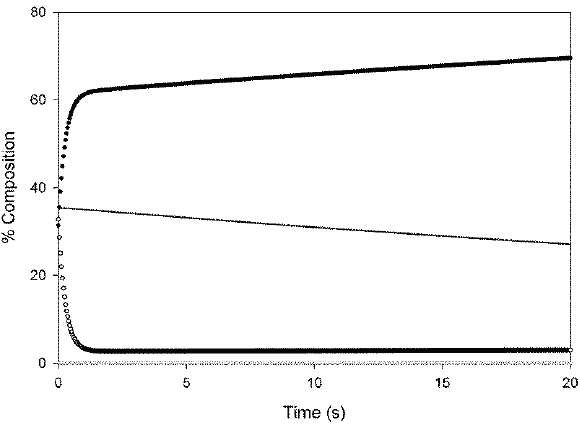
Figure 4. Simulation of the dynamics response of the neuroglobin redox cycle to rapid changes in oxygen concentration. The response, in the change of the level of the various forms of neuroglobin present in the redox cycle, to a rapid change in oxygen concentration from a fixed value of 50 μ M to a fixed value of 2 μ M is shown, as determined employing the redox cycling model. The hexa co-ordinate ferrous form is indicated by the closed circles; the ferric form by the descending line; the oxygenated form by the open circles and the penta co-ordinated ferrous form by the open squares (running along the x axis). A reduction rate of 0.015 s − 1 was employed in these calculations and a total neuroglobin concentration of 5 μ